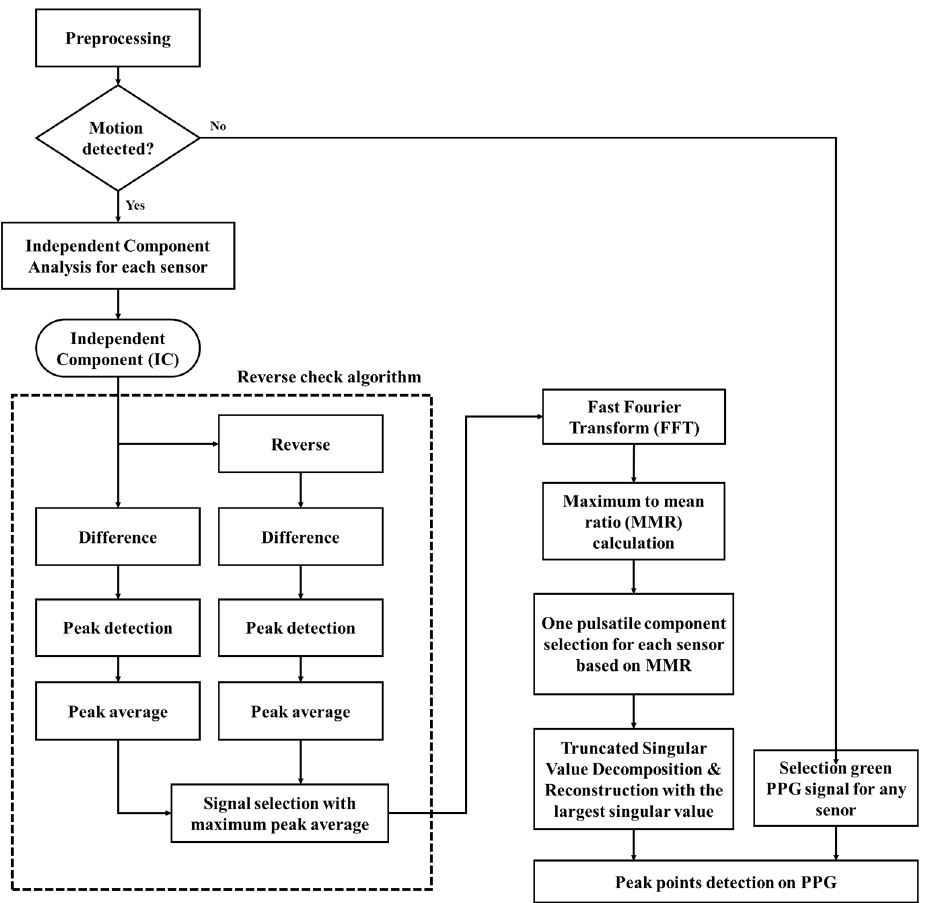
Figure 5. Flowchart of the proposed multi ‐ sensor ‐ based motion artifact reduction algorithm. (MMR is defined as Maximum to mean ratio).